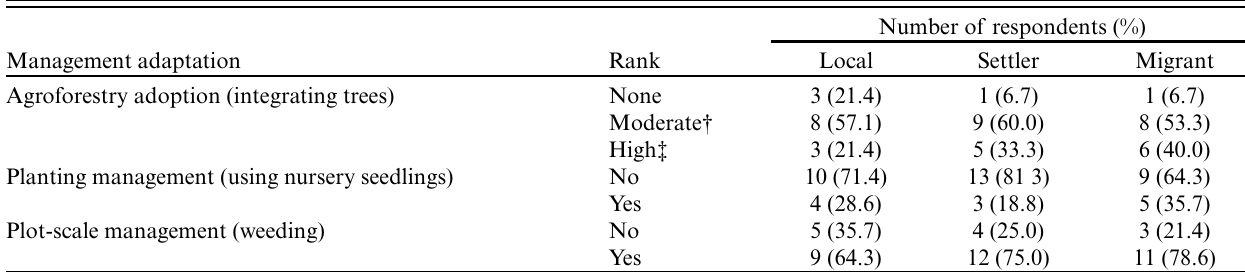
Table 4. Contingency table showing number (%) of respondents categorized into three settlement categories and their adoption of three identified management